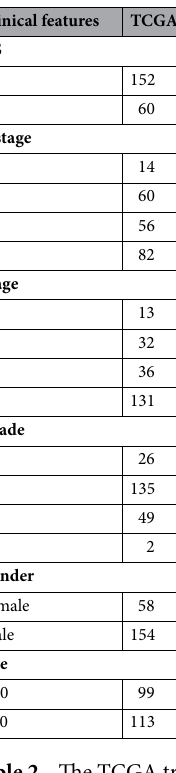
Table 2. The TCGA training set and TCGA test